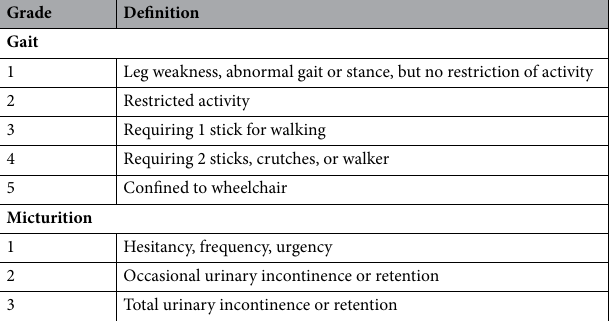
Table 1. The modified Aminoff-Logue scale for the assessment of patients’ functional